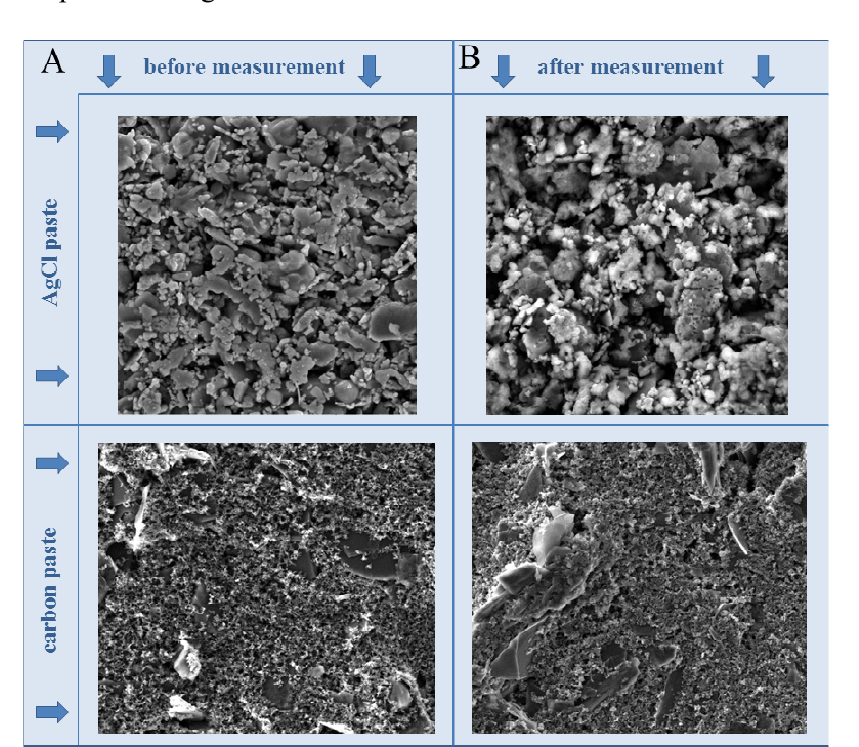
Figure 1. SEM photos of AgCl and carbon electrodes of SPE before and after